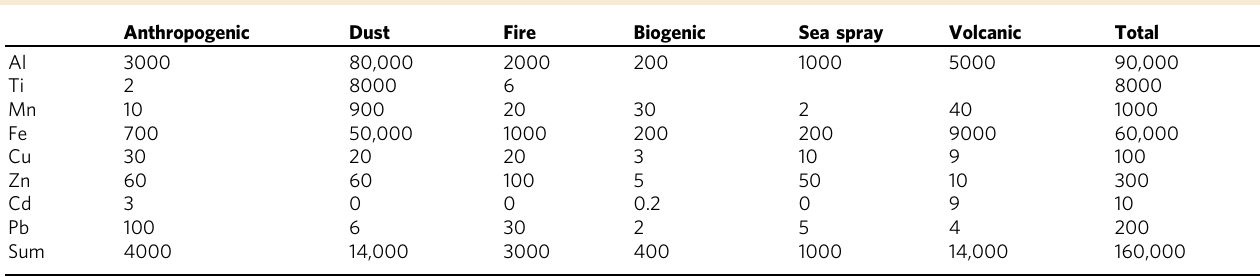
Table 1 Aerosol metal sources to the